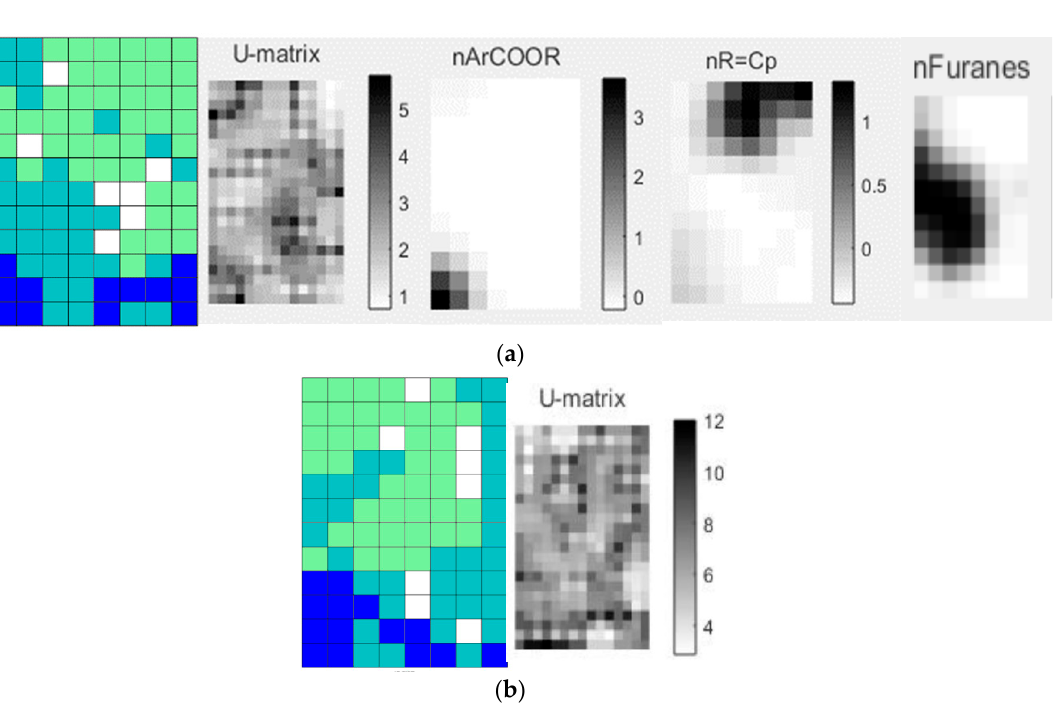
Figure 4. Self-organizing map obtained by the classification of the subfamilies Aju (light blue), Lam (green), Scu (dark blue) and generated descriptors: ( a ) SOM → molecular descriptors; U-matrix; nArCOOR; nR = Cp and nFuranes. ( b ) SOM fingerprint and U-matrix.